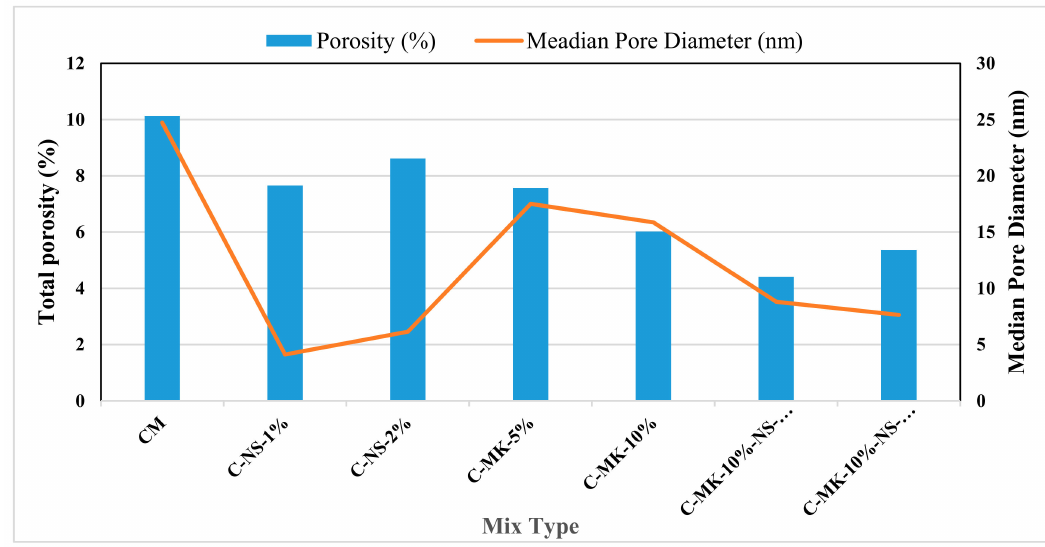
Figure 5. Total Porosity and Median Pore Diameter of all concrete